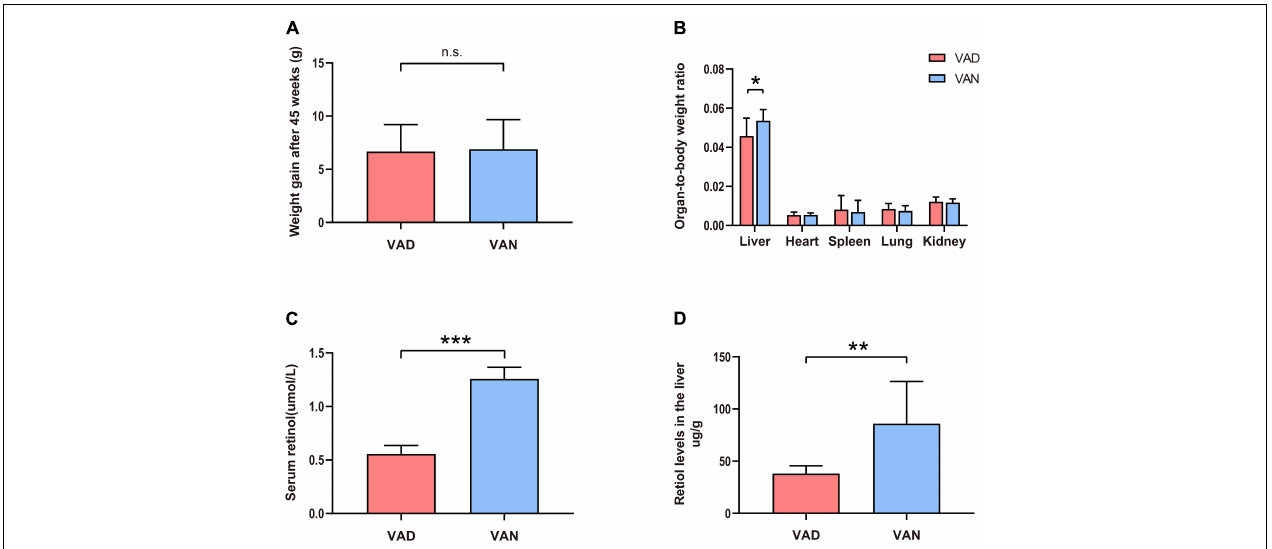
FIGURE 1 | Consumption of a vitamin A deficiency (VAD)-diet for 45 weeks led to reductions in the serum and liver retinol levels. (A) Weight gain of the amyloid precursor protein/presenilin 1 (APP/PS1) transgenic mice after 45 weeks on VAD-diet. (B) The organ-to-body weight ratio in the APP/PS1 transgenic mice after 45 weeks on the VAD-diet. (C) The serum retinol level of the APP/PS1 transgenic mice after 45 weeks on VAD-diet. (D) The liver retinol level of the APP/PS1 transgenic mice after 45 weeks on VAD-diet. VAD, vitamin A deficiency diet; VAN, vitamin A normal diet. n = 10 per group. ∗ P < 0.05, ∗∗ P < 0.01, ∗∗∗ P < 0.001, and n.s.,